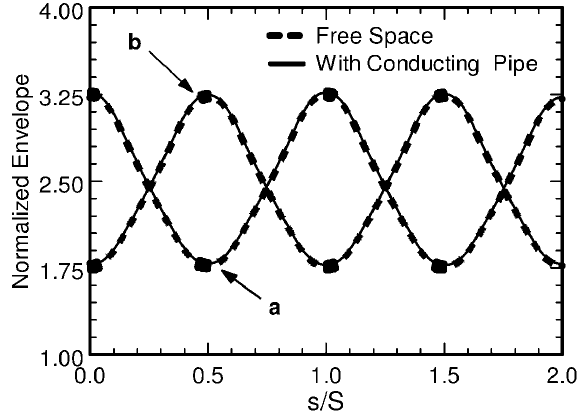
Figure 5 is a plot of ^ KK (cid:4) KS=" versus (cid:1) the unstable regions of the slightly mismatched beam (cid:4) 80 0 , ^ KK (cid:4) - envelopes for + (cid:4) 0 : 5 and g (cid:4) 0 for three cases